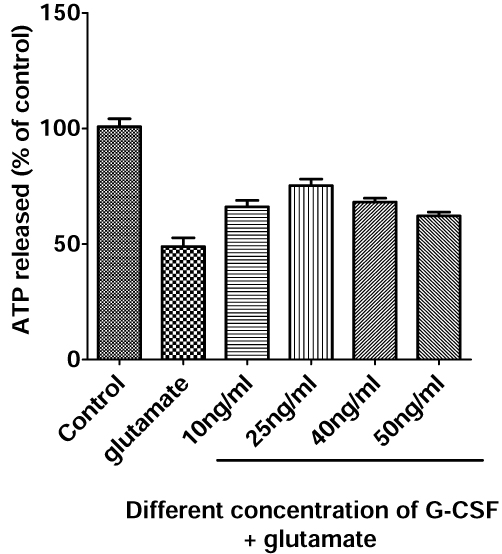
Neuroprotective effect of G-CSF against glutamate-induced excitotoxicity - A dose-dependent study. Primary cortical neurons were preincubated with 10, 25, 40 and 50ng/ml G-CSF for 1 hour, then exposed to 100uM glutamate for 4 hours. Cell viability was measured by ATP assay.